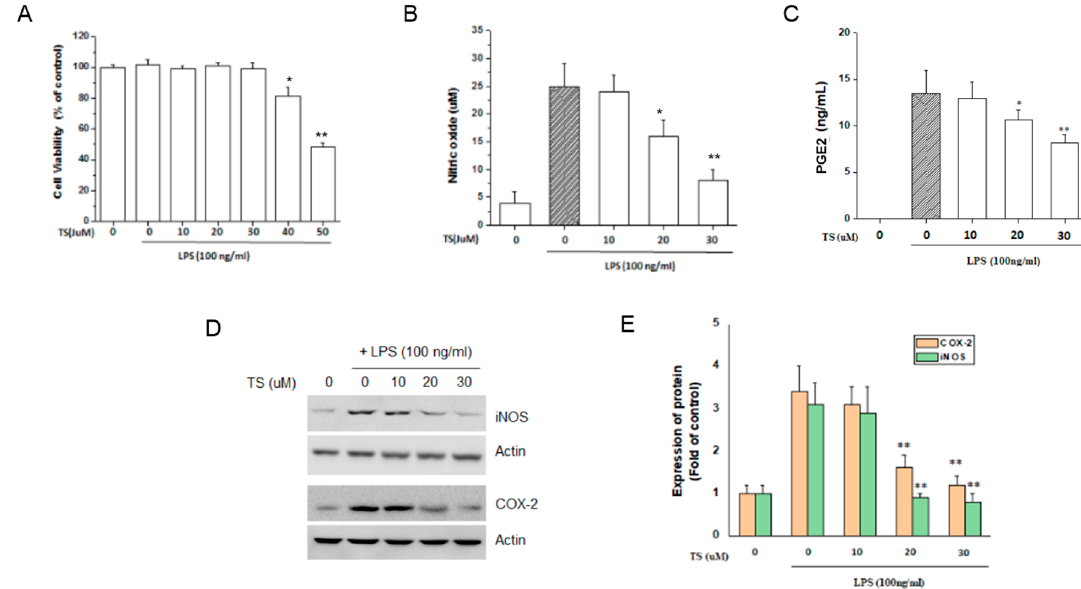
Figure 2. Effects of TS on nitric oxide (NO) and prostaglandin E2 (PGE2) production in lipopolysaccharide (LPS)-stimulated macrophages. RAW 264.7 cells were pretreated with TS for 1 h at various doses. The cells were then stimulated with LPS (100 ng/mL) for 24 h. ( A ) Cell viability was assessed by MTT assay; ( B ) The level of NO production was determined by measuring the accumulated nitrite in the culture medium ( C ) PGE2 production in the culture media was determined by enzyme-linked immunosorbent assay (ELISA); ( D ) cyclooxygenase (COX)-2 and Inducible nitric oxide synthase (iNOS) expression was analyzed by western blot analysis using β -actin as an internal control ( E ) Relative expression of the proteins at each TS concentration to the treatment control sample from three independent experiments with standard deviation. * p < 0.05, ** p < 0.01 vs. LPS-treated sample. All experiments were performed in triplicate.